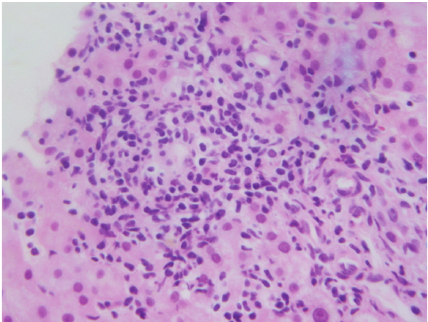
Figure 3: Liver biopsy showing lymphocytic and plasma cell infiltrate in Subject 3 (hematoxylin and eosin stain, magnification ×